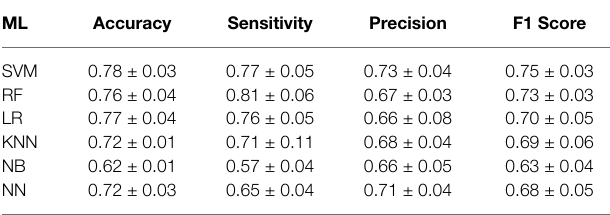
TABLE 1 | Validity evaluation of different prediction models for the 5,000 m final of women’s all-around speed skating event.